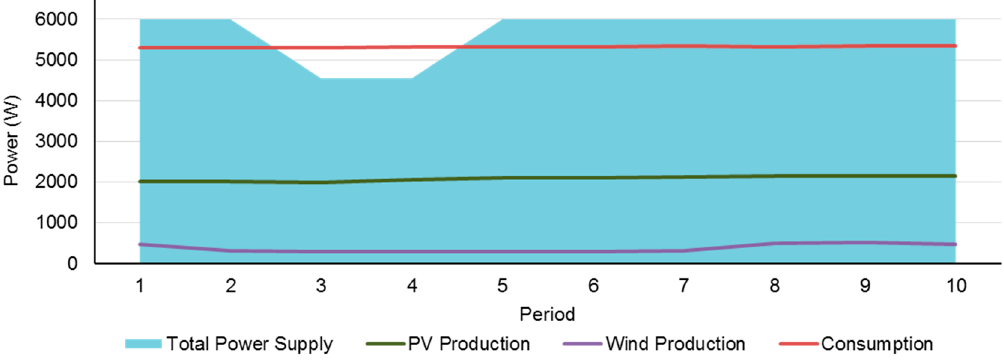
Figure 5. The microgrid model used in the 33 bus network.